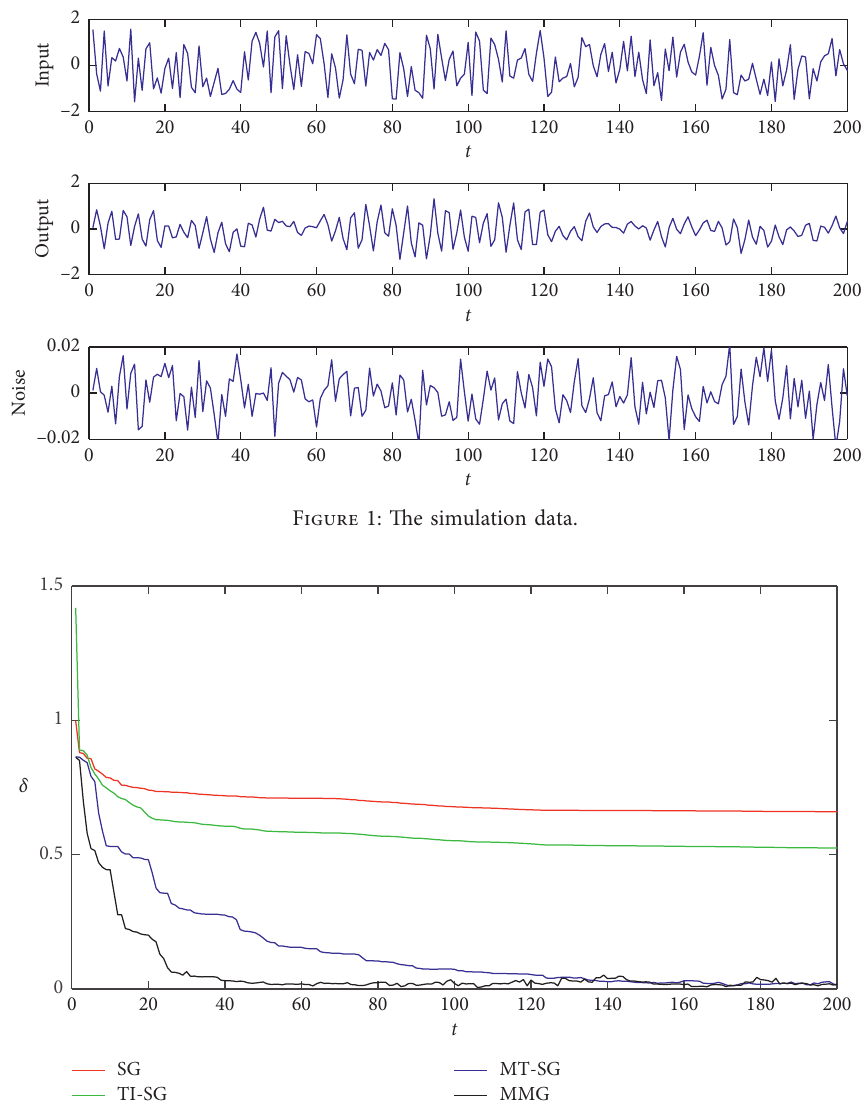
Figure 2: The parameter estimation